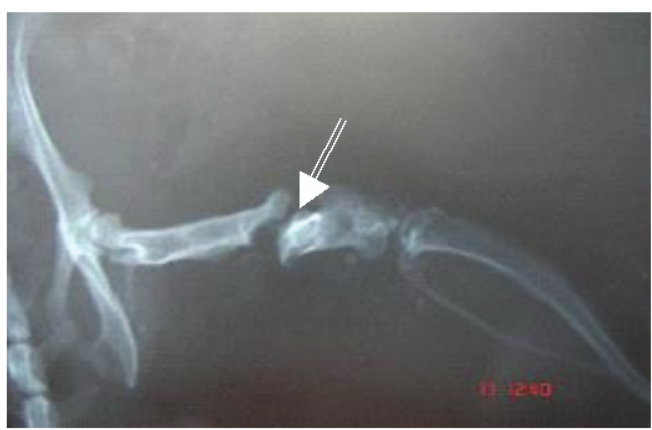
FIGURE 5 - Radiography 120 days after the surgical procedure showing the absence of bone calcification (arrow)